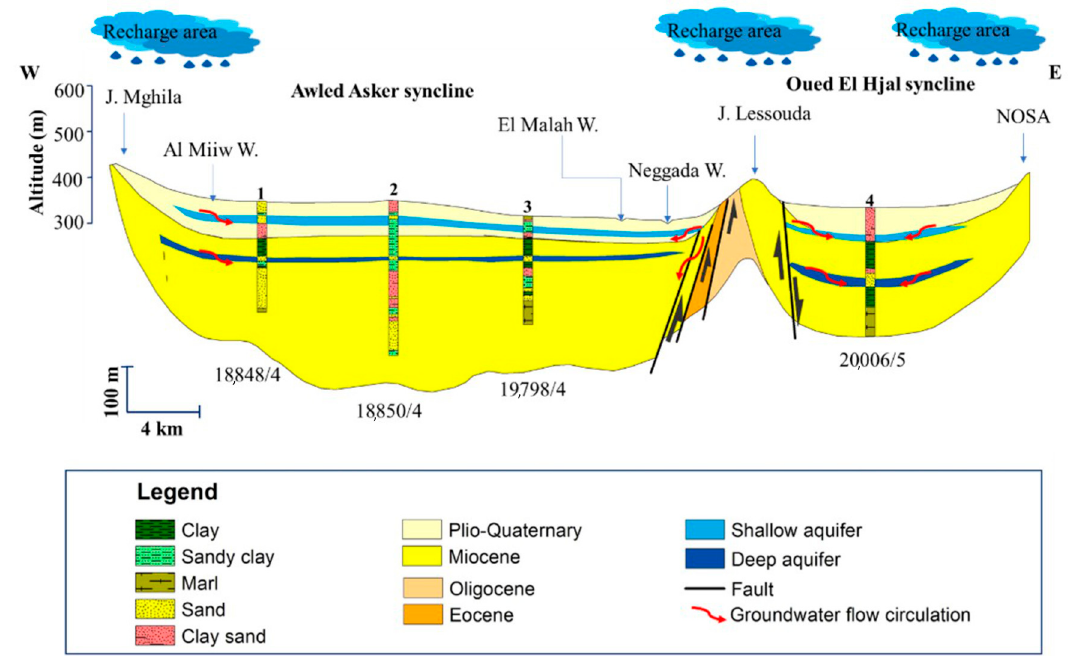
Figure 3. Simplified cross section elaborated from lithostratigraphic sections of boreholes.